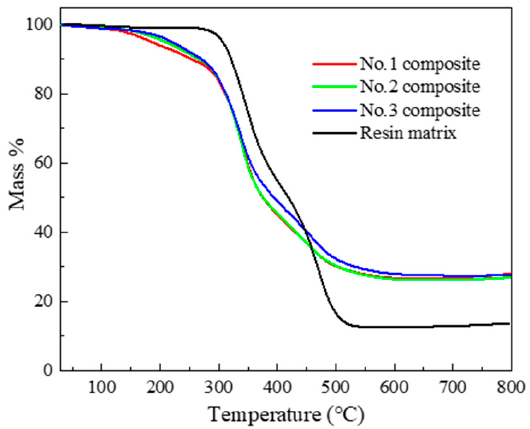
Table 2. Insulation characteristics of the polyurethane composites.